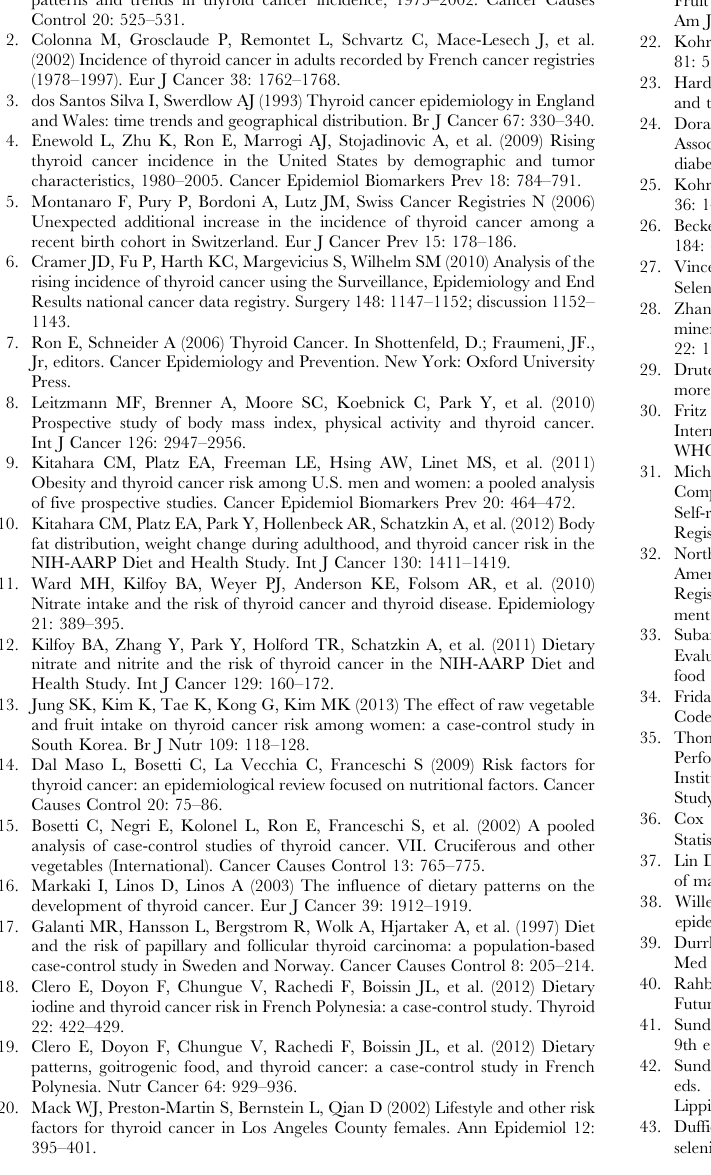
Table S8 Hazard Ratios (HRs) and corresponding 95% confidence intervals (CIs) for follicular thyroid cancer by quintile of micronutrient intake among women in The NIH-AARP Diet and Health